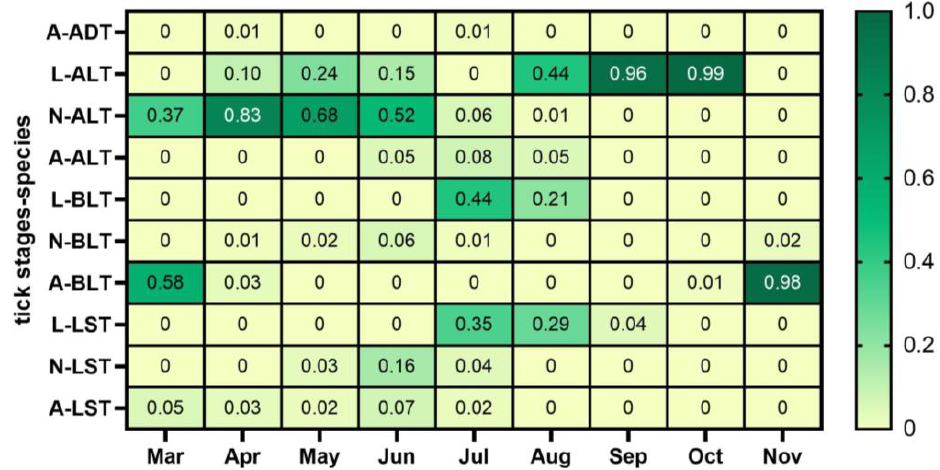
Figure 6. Map of the proportion of relative abundance observed of each stage and tick species in the ecotone. Life stages: larvae (L), nymphs (N), and adults (A). Tick species: Dermacentor variabilis (American dog tick, ADT), Haemaphysalis longicornis (Asian longhorned tick, ALT), Ixodes scapularis (blacklegged tick, BLT), and Amblyomma americanum (lone star tick,